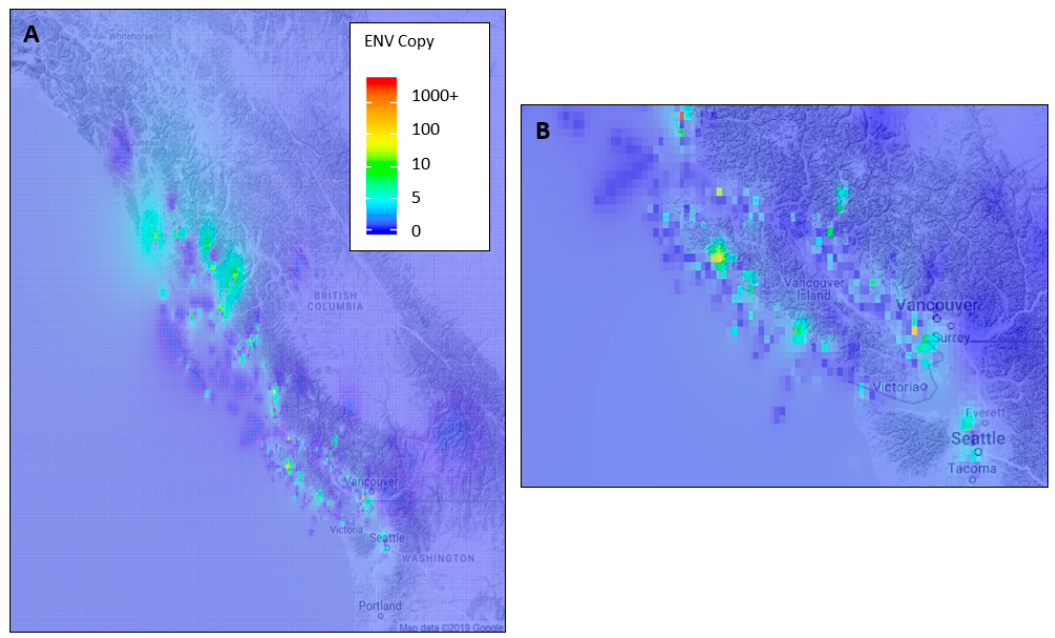
Figure 3. ( A ) Full sampling area heat map of the mean calculated ENV copy number, based on interpolated values. Copy number values are binned into 6 numerical categories (see color legend), ( B ) shows Vancouver Island inset map. Adults and smolts of all species are shown and LOD criteria are not applied.